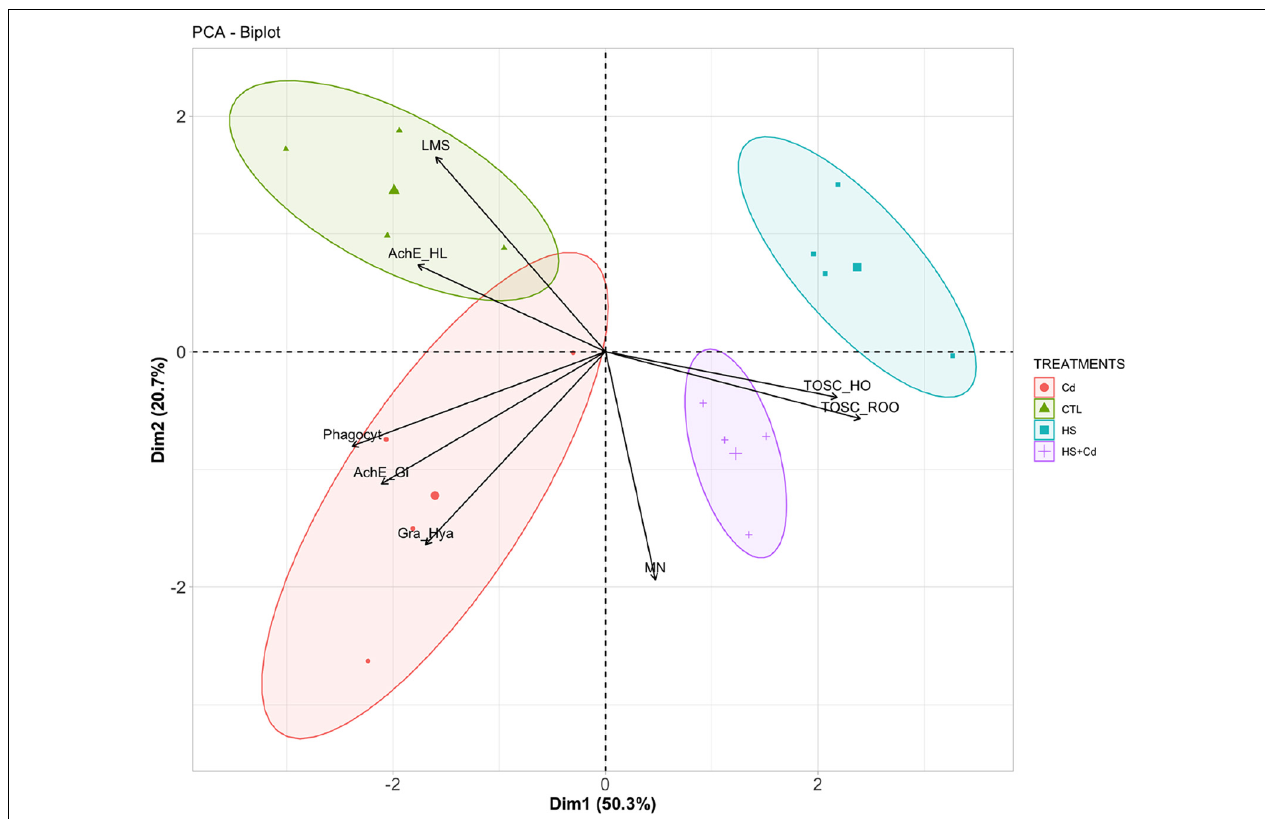
FIGURE 5 | Graphical representation of principal component analysis. CTL, Control; Cd, Cadmium (20 µ g/L) at control temperature; HS, heat stress (25 ◦ C); HS + Cd, heat stress (25 ◦ C) + cadmium (20 µ g/L)—each variable contribution to the separation is represented by